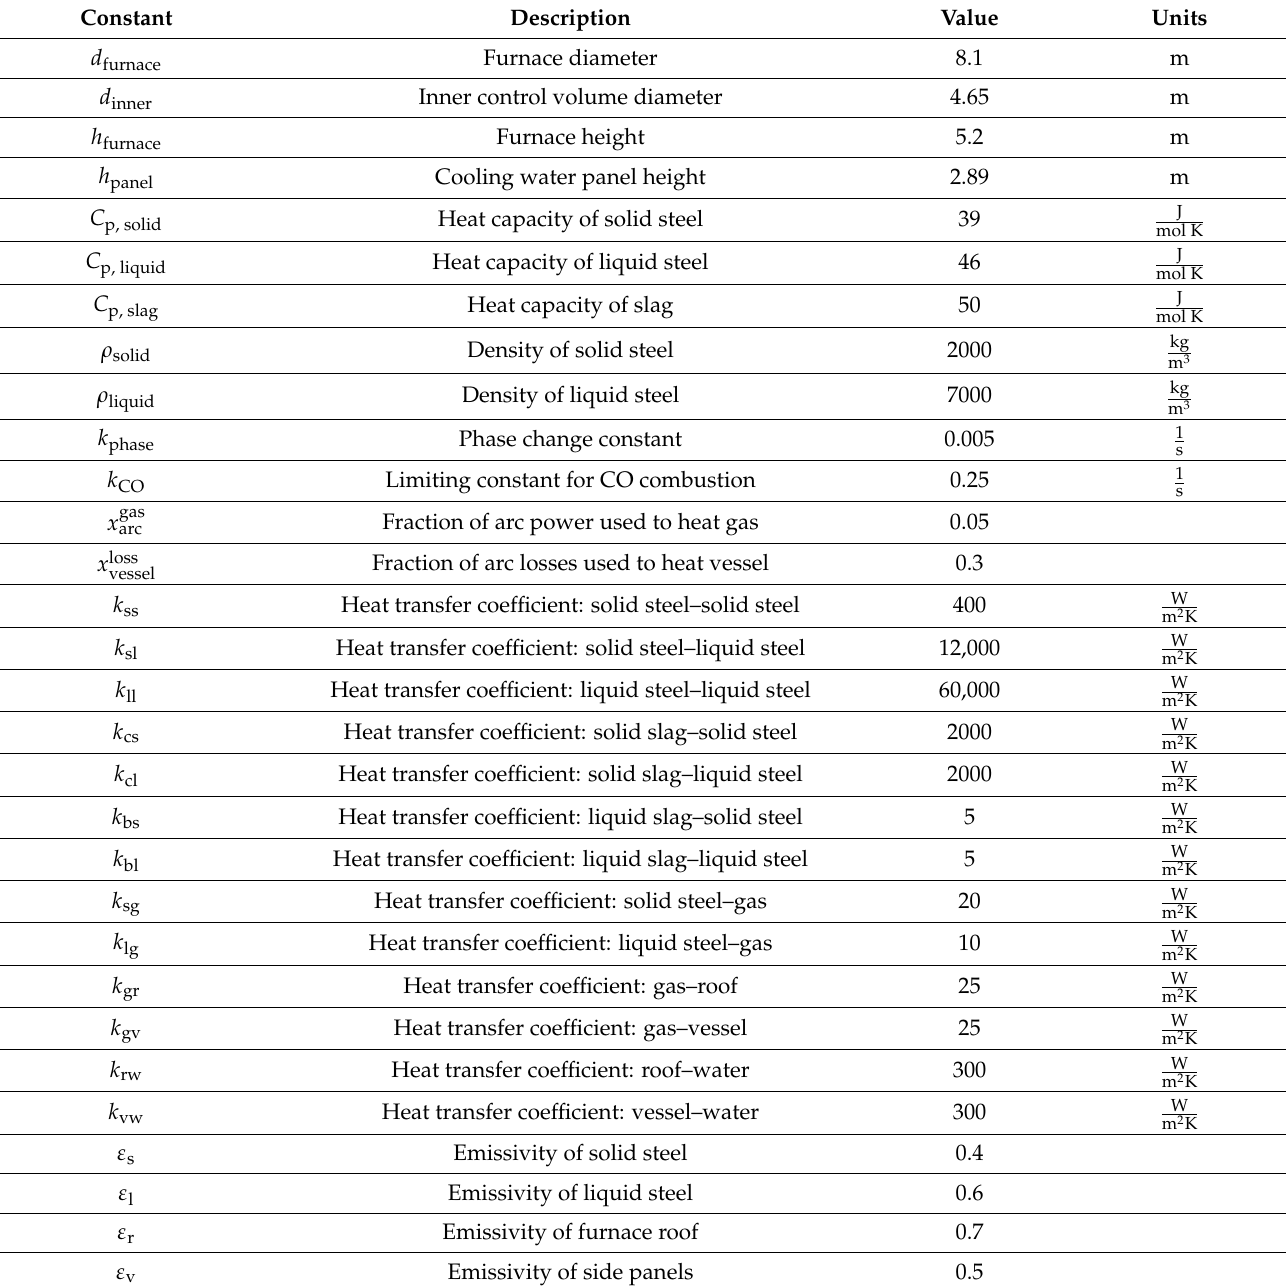
Table A6. Model constants and dimensions. An empty entry in the Units column indicates a unitless quantity.